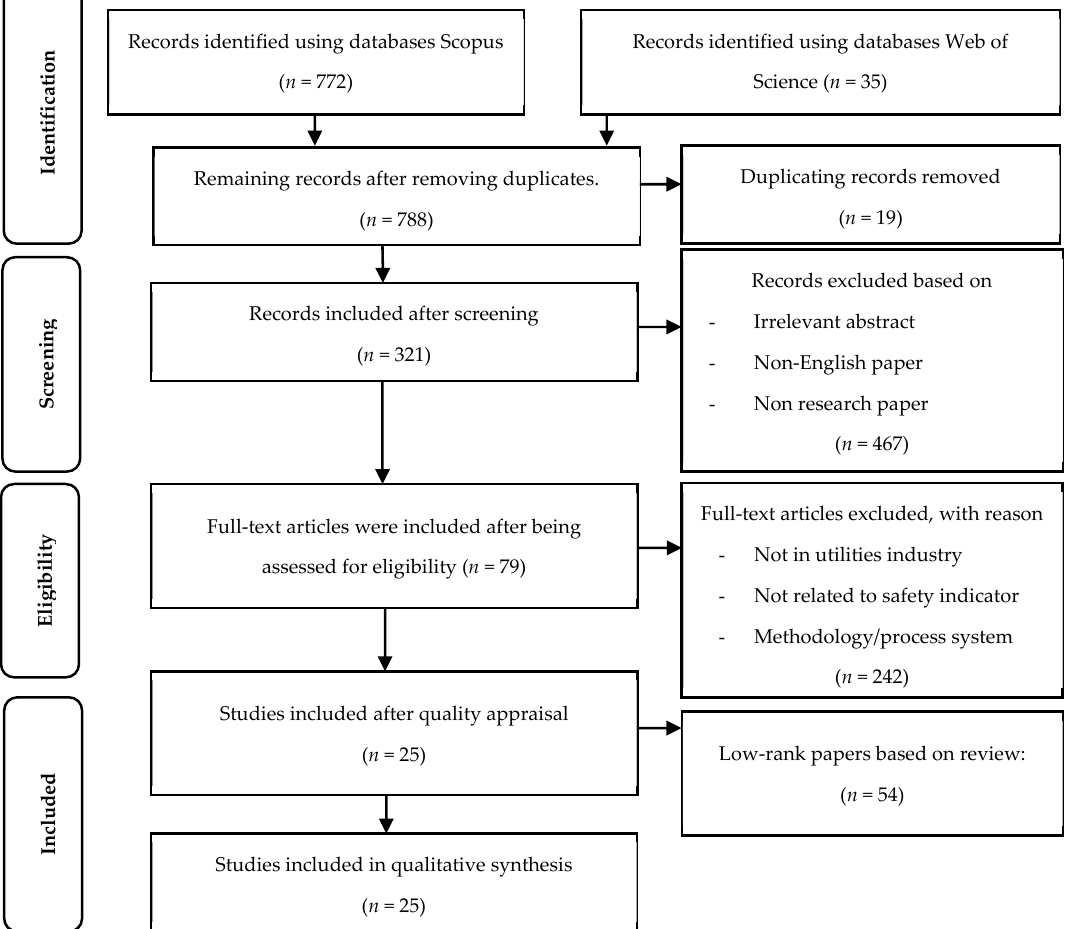
Figure 1. This describes the main processes based on PRISMA.